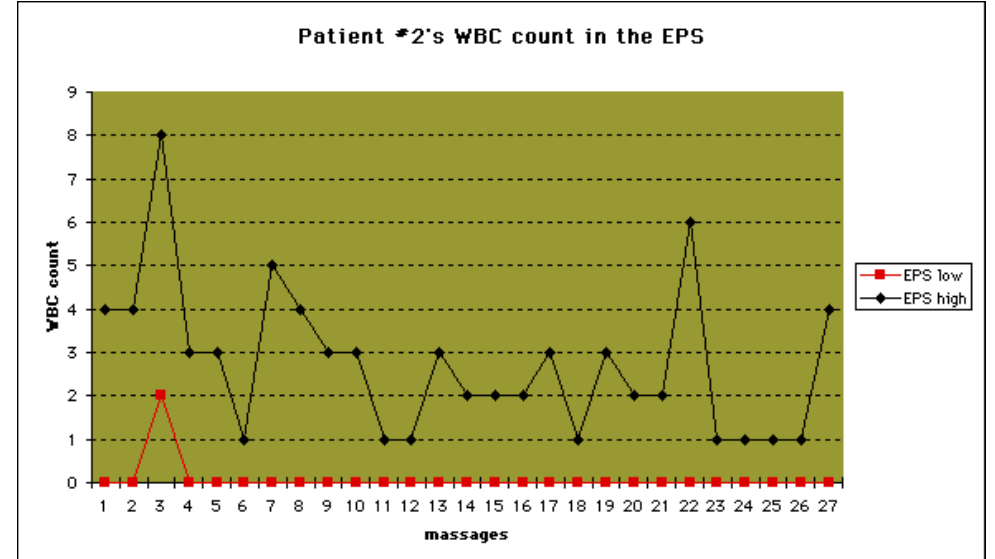
FIGURE 3. Changes in the WBC counts of patient #2 over 27 prostatic massages.